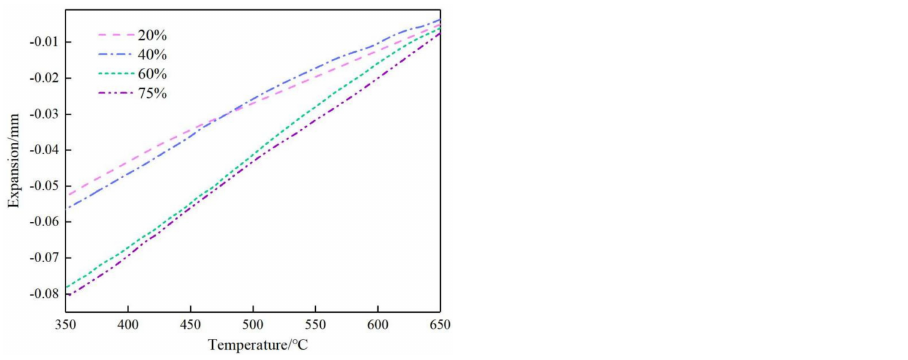
Figure 13. Expansion − temperature curves during the cooling process at different deformation